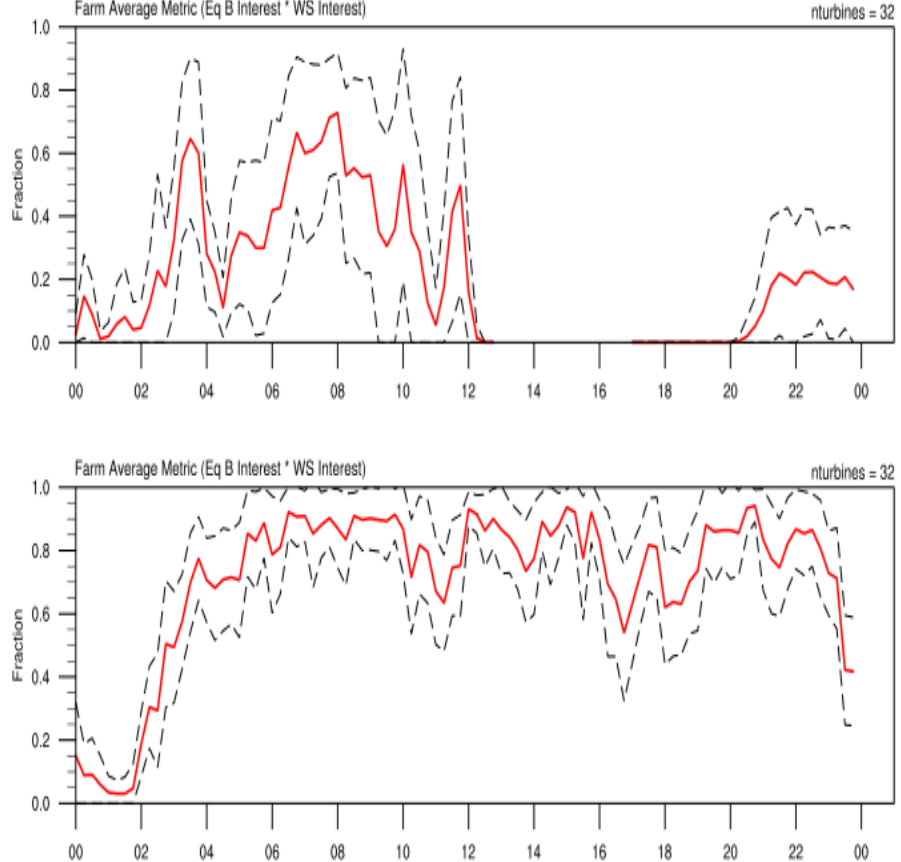
Figure 12. Wind speed weighted metric to identify periods when power production was less than expected and wind speeds were high enough to have confidence in the manufacturer’s power curve (i.e., not in the lower tail of the curve). The red line shows the farm average, while the black dashed lines show +/- the standard deviation for the farm. Top panel is for 25 December 2014, and bottom panel is for 26 December 2014. Higher values indicate a higher likelihood of icing (or curtailment).